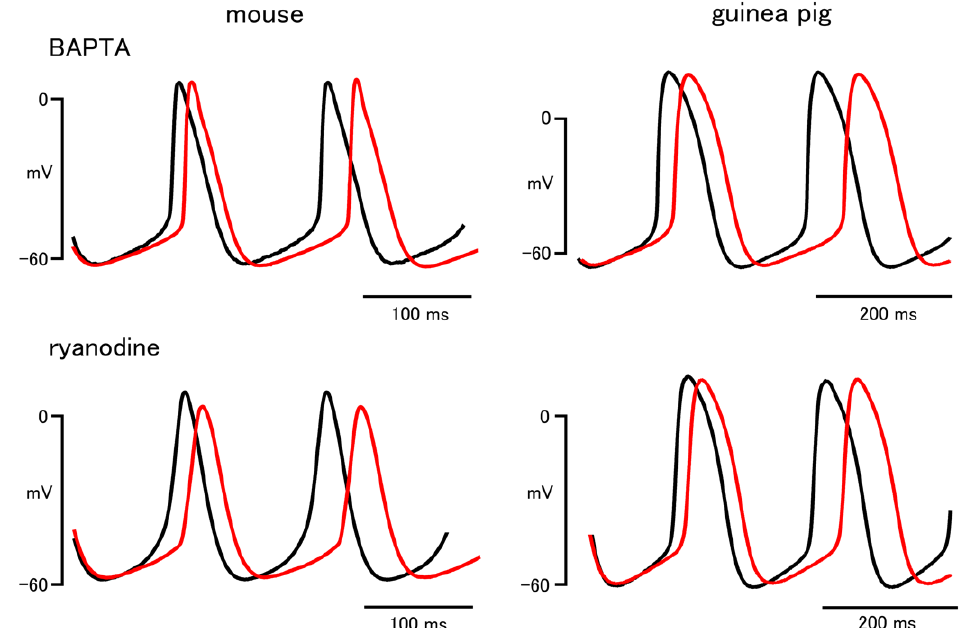
Figure 1. Effects of BAPTA and ryanodine on the sinus node action potential of the mouse and guinea pig. Typical traces before (black lines) and after (red lines) application of 300 µ M BAPTA (upper) and 0.1 µ M ryanodine (lower). Table 1. Action potential parameters before and after application of BAPTA and ryanodine. BAPTA Mouse Guinea Pig